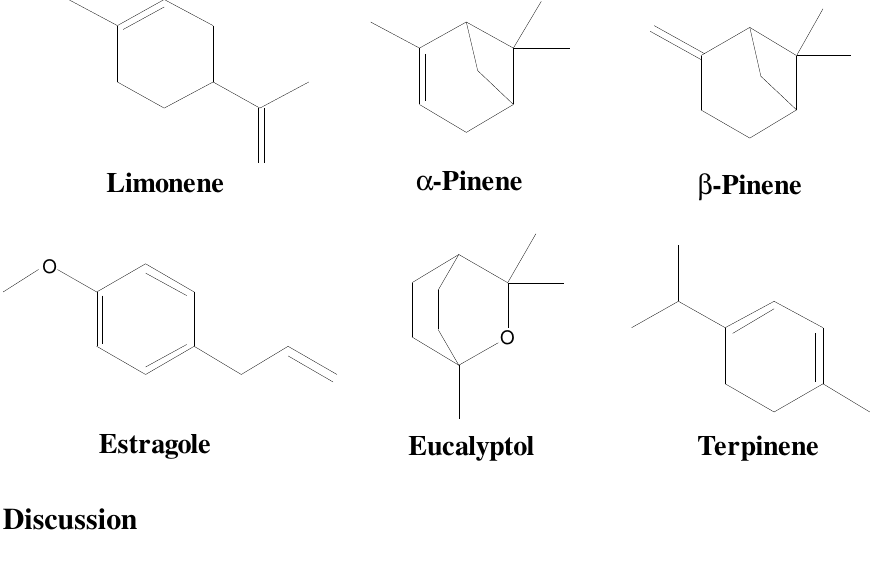
Table 1. A normalized response of the MIP-layers to limonene and eucalyptol respectively is